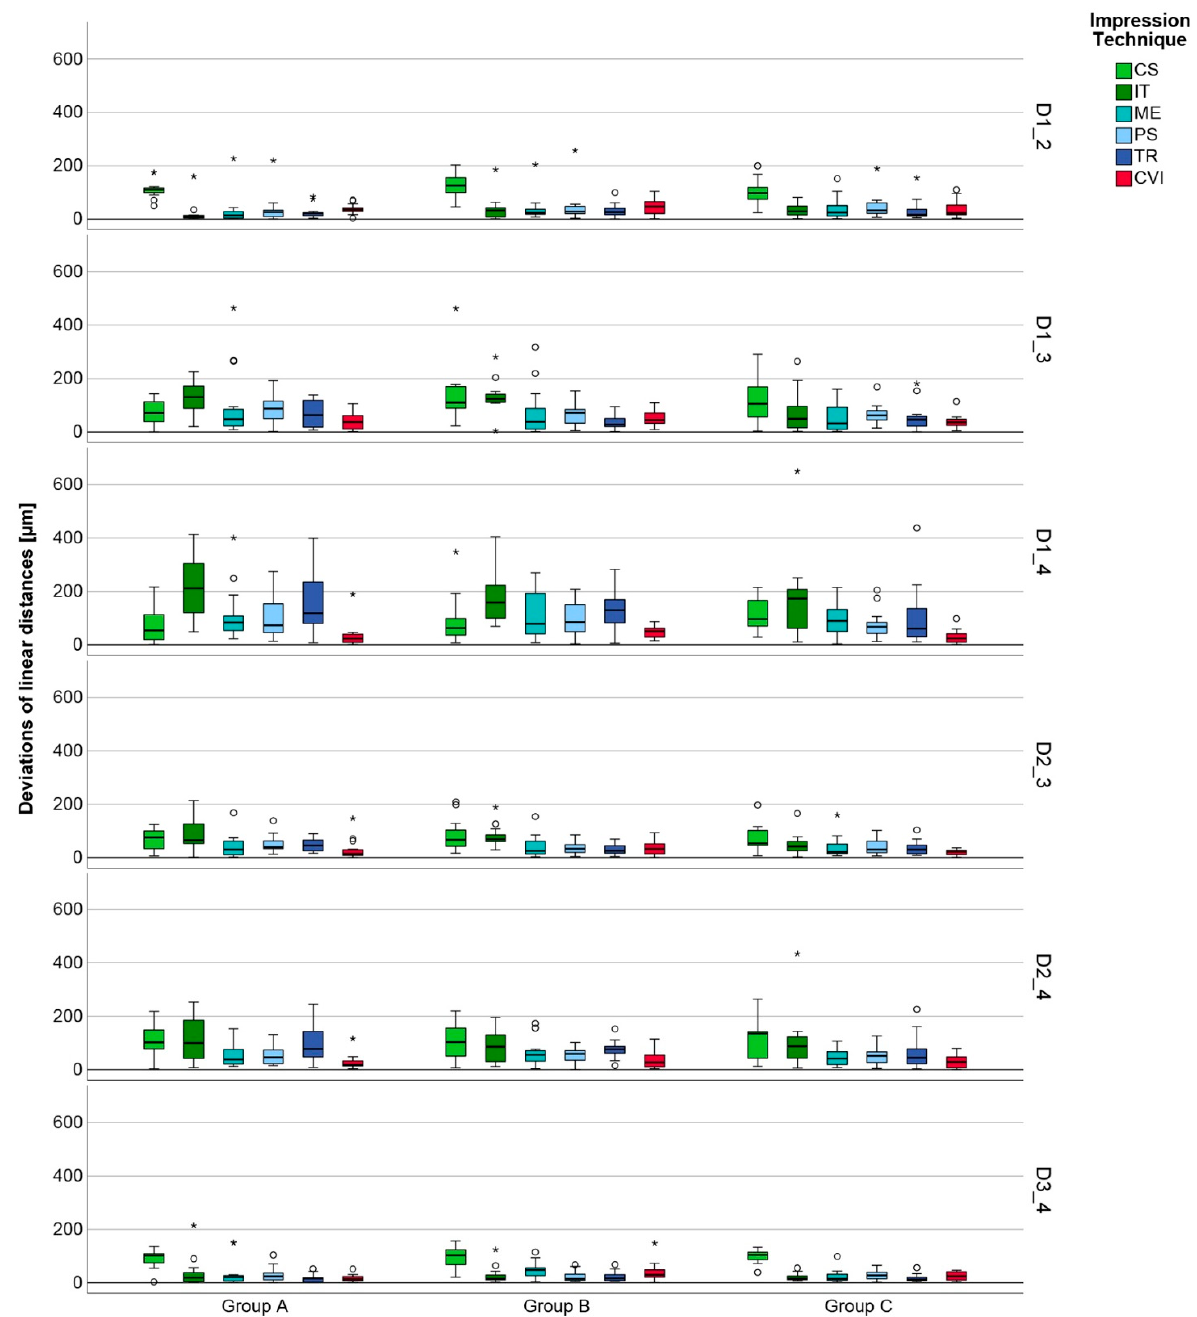
Figure 5. Boxplot diagram of the deviations of the linear distances (D1_2, D1_3, D1_4, D2_3, D2_4, D3_4) in group A, B, and C for the six techniques (CS = CS 3800, IT = iTero Element 5D, ME = Medit i700, PS = Primescan, TR = Trios 4, CVI = conventional impression); outliners (o), extreme values (*).